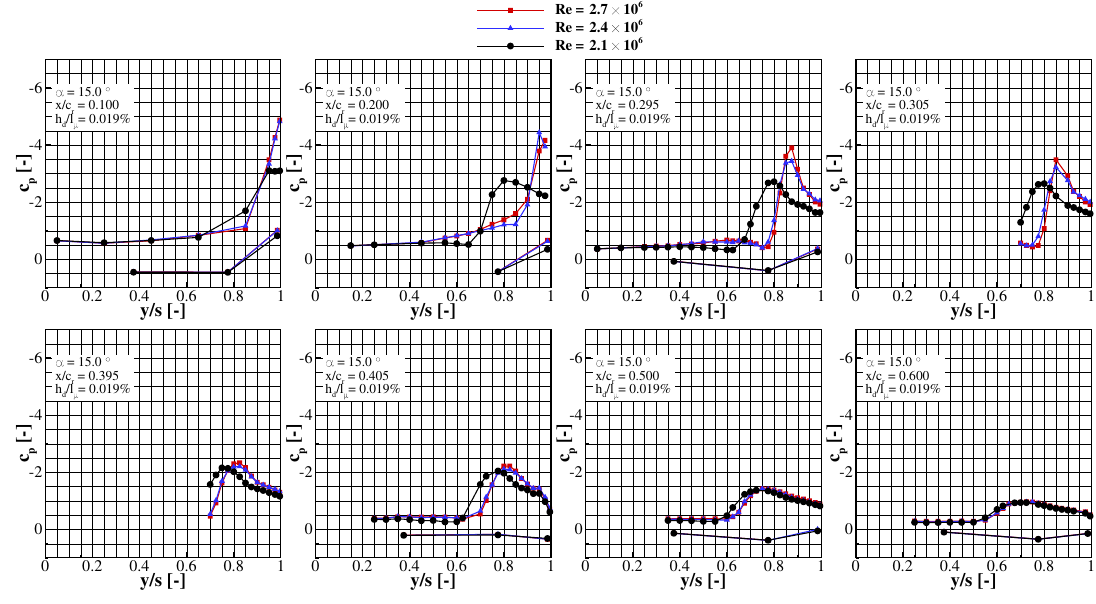
Figure 10. Reynolds number effect on the spanwise mean pressure coefficient distribution at α = 15 ◦ —case with trip dots h d / l µ =